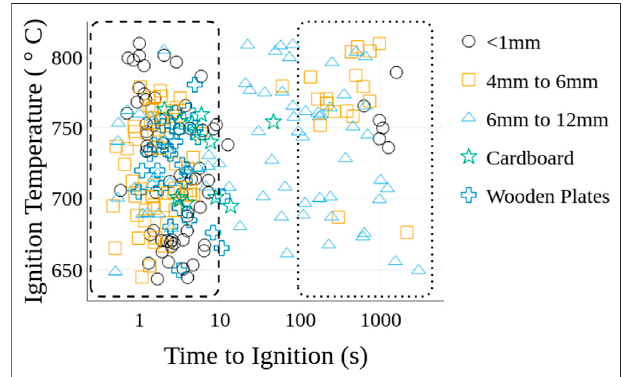
FIGURE 4 | Time to ignition and heater temperature at ignition for all fuel bed materials. The dashed and dotted boxes emphasize the two general times-scales associated with